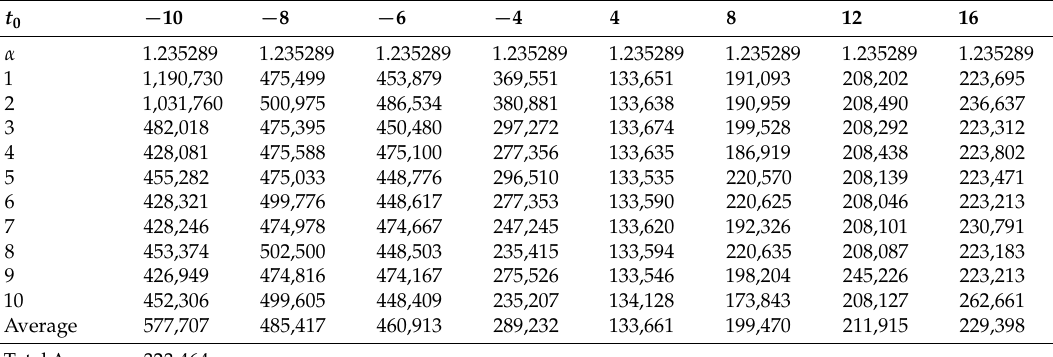
Table 7. Running time for different initial values of Example 3 by our method with test point p = (30, 40, 50, 60, 70).